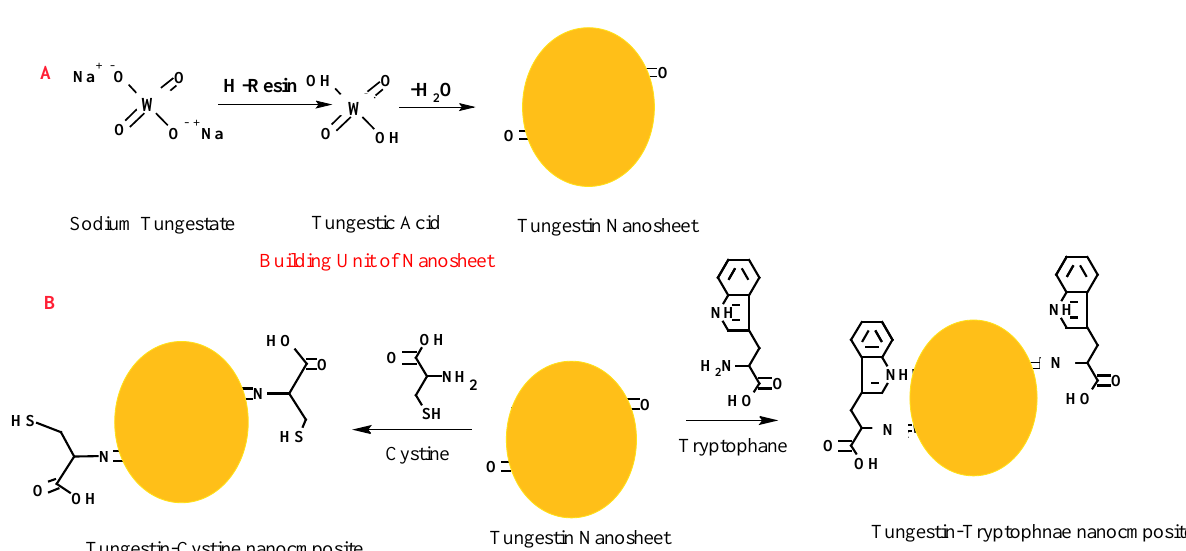
Figure 1. Preparation of WO 3 NPs through cation resin ( A ) and interaction of the prepared WO 3 NPs with amino acids L -tryptophan or L -cysteine ( B ).